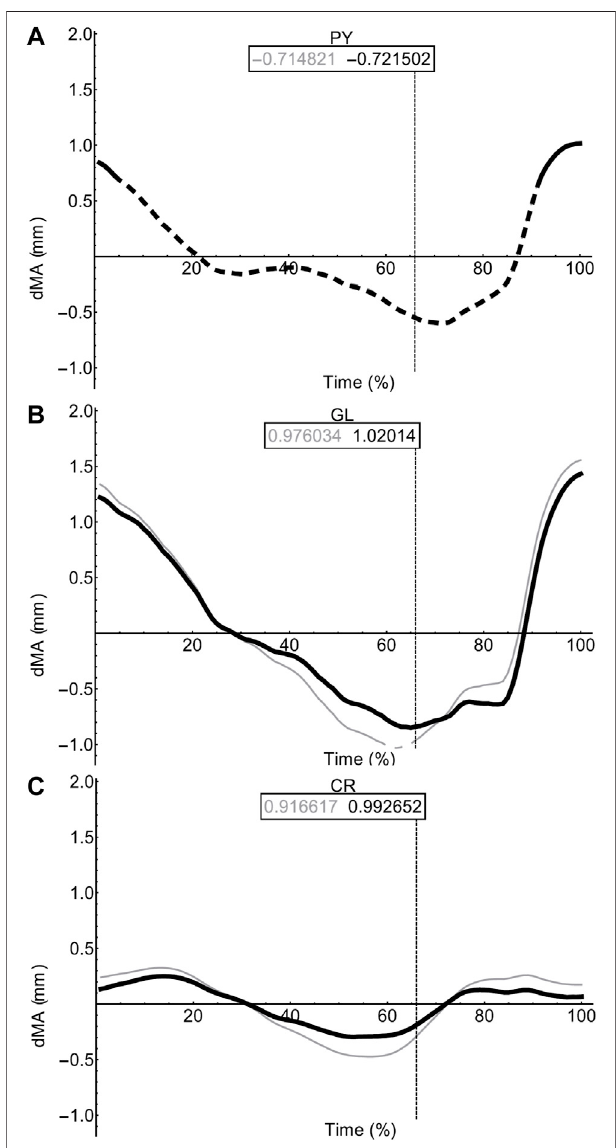
FIGURE 9 | Miscellaneous muscle moment arms during walking. Changes in moment arm (dMA) versus time are shown for pyriformis, PY (A) , gluteus maximus, GL (B) , cruralis, CR (C) . for simulations with a mobile pelvis (naturalcondition;black)versusa fi xedpelvis(simulatedcondition;grey). See Figure 7 caption for further details. Solid versus dashed lines represent positive moment arms ( fl exion - — femur protraction) versus negative (extension — femur retraction) such that a change from solid to dashed indicates a change in muscle function.